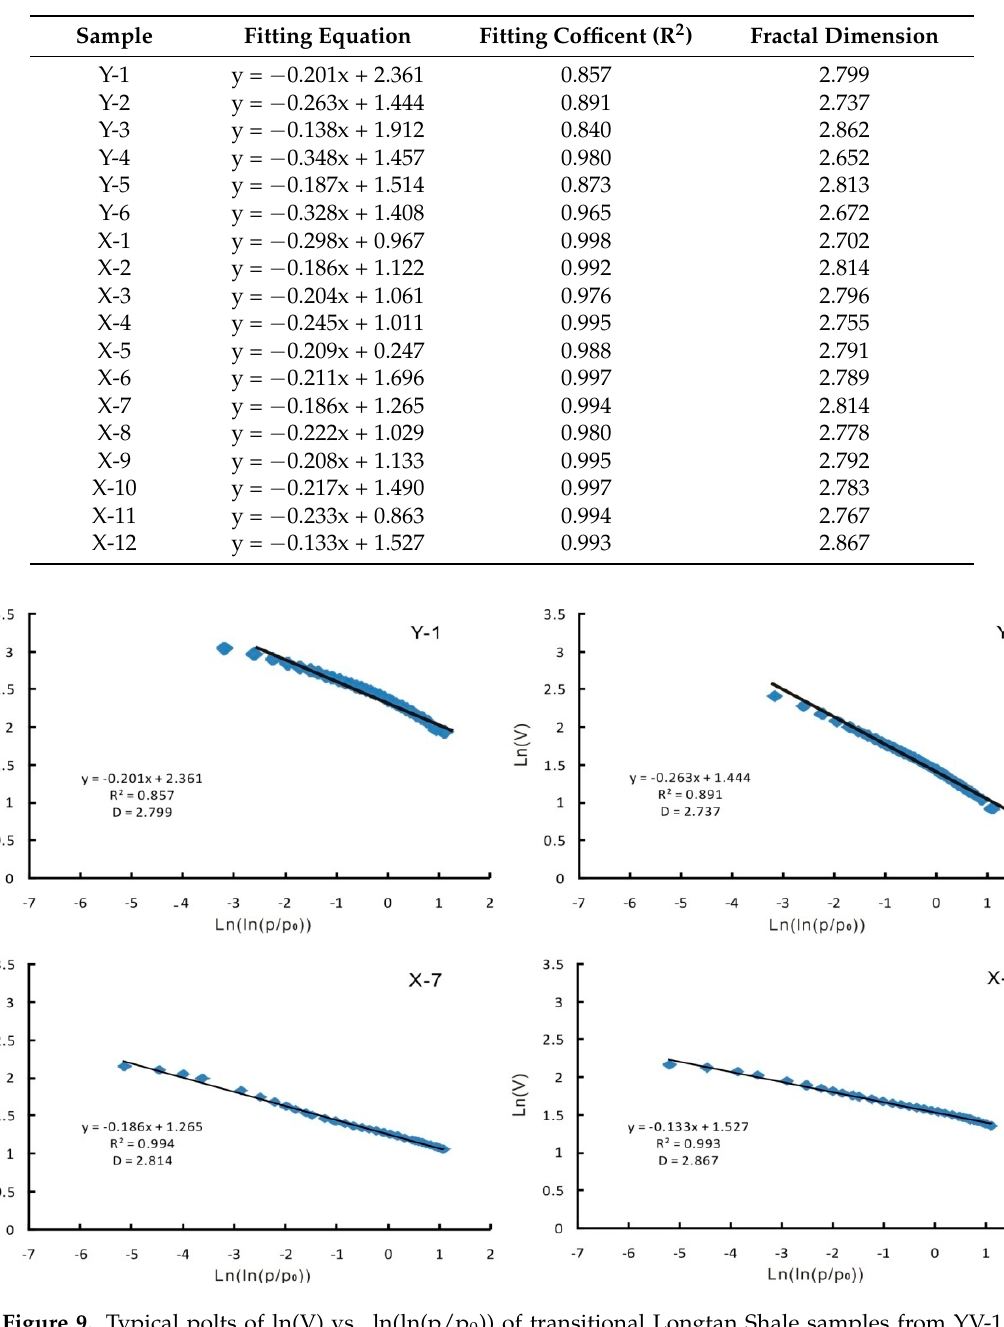
0 )) of transitional Longtan Shale samples from YV-1